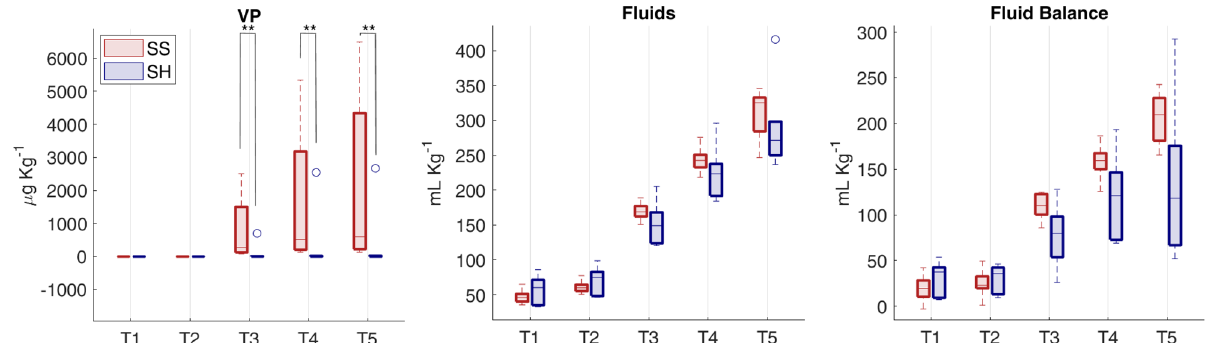
Figure 3. Distributions of administered vasopressors (VP), fluids and fluid balance for the two groups at each time point. Indices are computed as cumulative values from the start of the experiment until each time point and are normalized with respect to each pig’s weight. Comparison between Sepsis and Sham: ** p -value < 0.01 (Wilcoxon rank sum test).